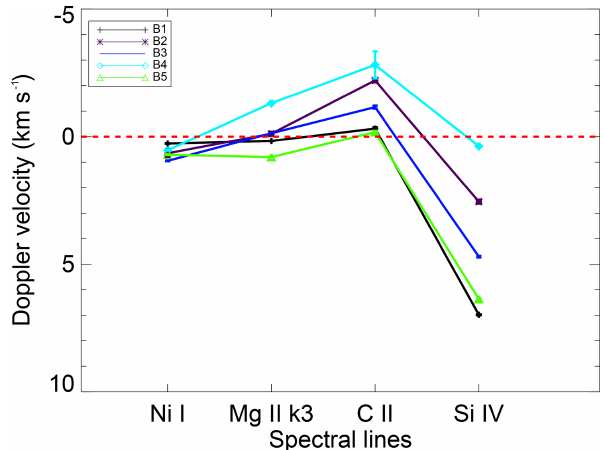
Figure 11. Average Doppler velocity variations for different spec- tral lines dominating at different heights in the solar atmosphere for boxes B1, B2, B3, B4, and B5 at the foot points of quiescent coronal